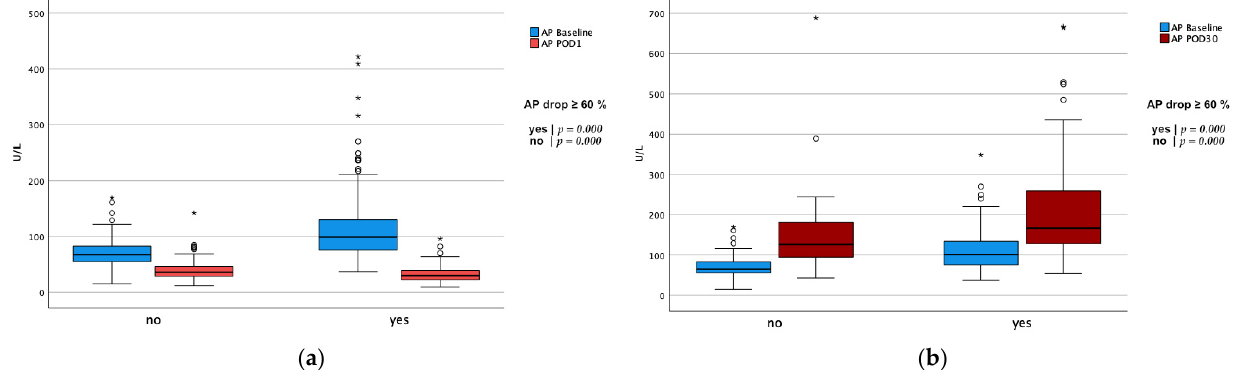
Figure 3. Comparison of the alkaline phosphatase levels at the baseline to different postoperative timepoints dependent on the initial drop of alkaline phosphatase. p -values were calculated for differences between the timepoints using the Wilcoxon signed-rank test. Statistical significance was obtained with an altered α level (set at 0.025). Using SPSS, values between the 1.5- and 3-fold IQR of Q3 are labeled as outliers and marked with a circle (°). Extreme outliers (3-fold IQR of Q3) are marked with an asterisk (*). ( a ) Comparison of AP baseline to POD 1. ( b ) Comparison of AP baseline to POD 30.